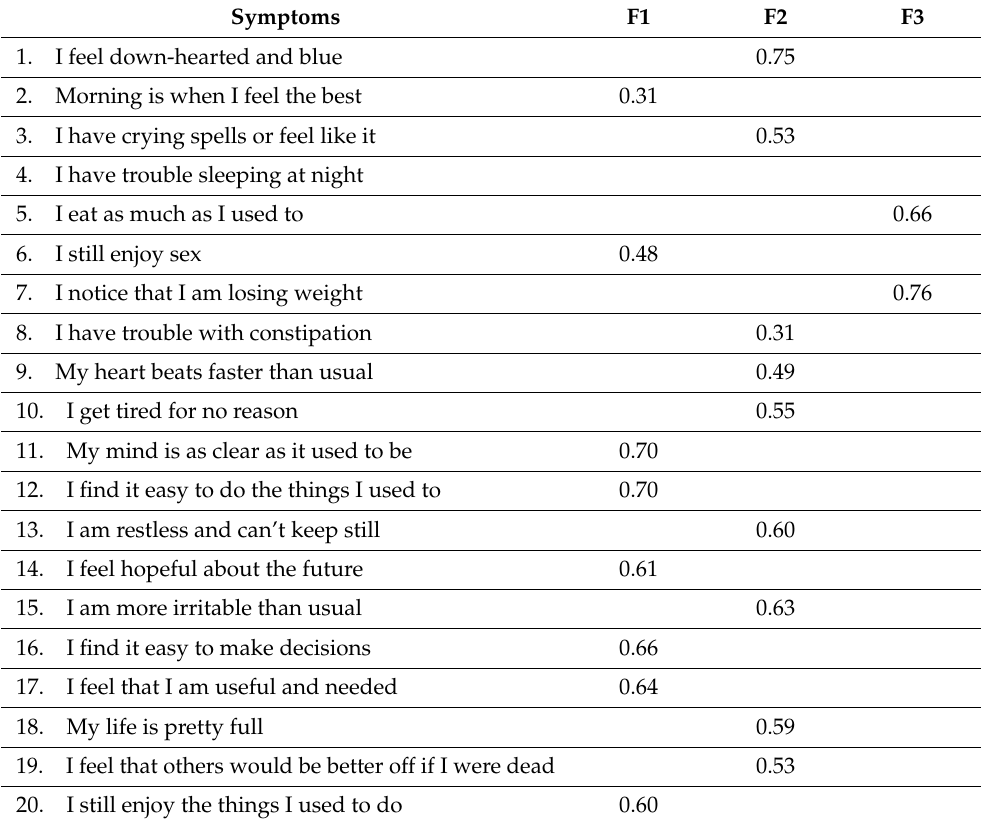
Table 1. Three-factor structure of the Zung Self-Rating Depression Scale in the study